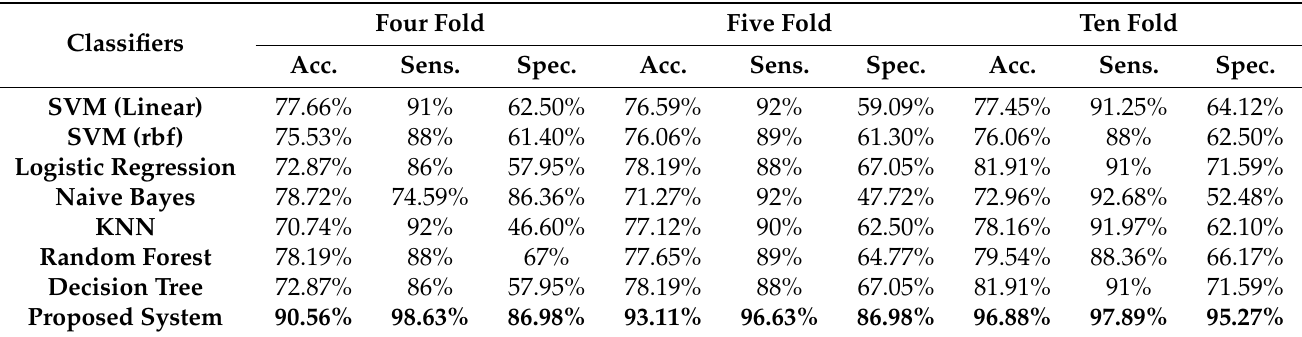
Table 2. Comparison between the proposed system and other ML-based classification. Note that Acc.: Accuracy, Sens.: Sensitivity, Spec.: